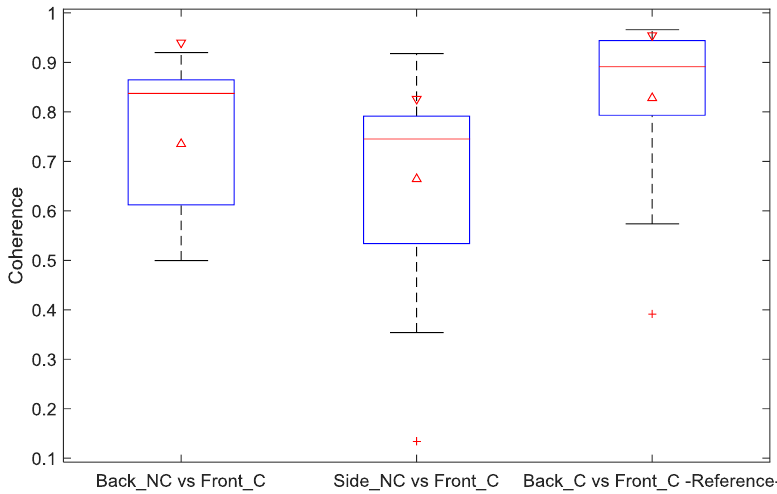
Figure 5. Coherence boxplot of signals between 0.67 Hz and 40 Hz. Left box shows the coherence between ccECG from the back and contact ECG from the front; middle box shows the coherence between ccECG from the side (left and right) and contact ECG from the front; right box shows the coherence between contact ECG from the back and contact ECG from the front for reference on the maximum similarity of signals obtained with the same reference method from these two locations. ccECG signals evaluated correspond to the collection of every best segment per measurement. NC: Non-Contact; C: Contact.